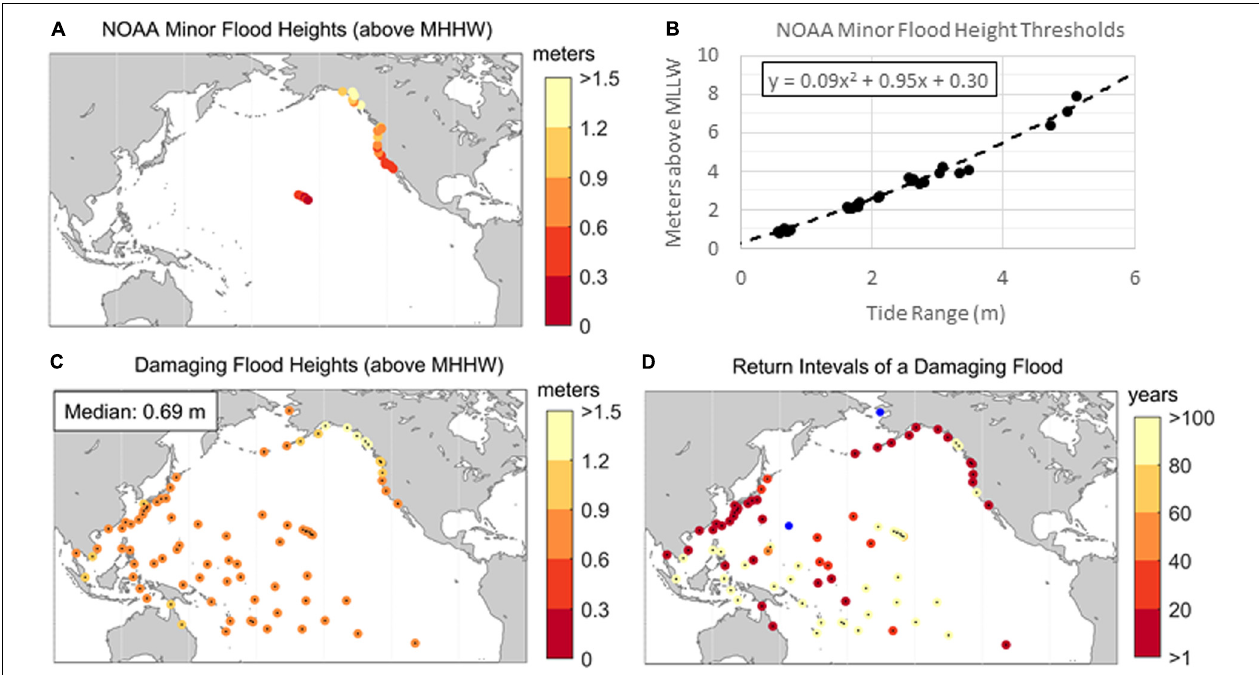
FIGURE 9 | (A) NOAA coastal thresholds for minor flooding along U.S. Pacific coastlines, (B) regression of NOAA minor flood threshold heights along Pacific coastlines shown in (A) with tide range, (C) proposed heights of a Pacific damaging flood level (minor flood threshold +0.3 m) at TGs in this study and (D) return intervals of the damaging flood level based upon the RFA LESLs. The two outlier TGs in blue have return intervals less than 0.1 years.